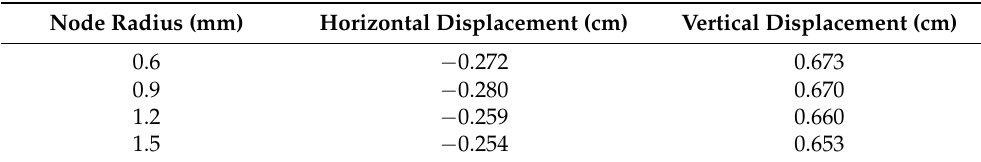
Figure 4. Physical field at each node radius, displacement field in x-direction and displacement field in y-direction: ( a ) r = 0.6 mm;( b ) r = 0.9 mm; ( c ) r = 1.2 mm; ( d ) r = 1.5 mm. Table 2. Horizontal and vertical displacements for different node